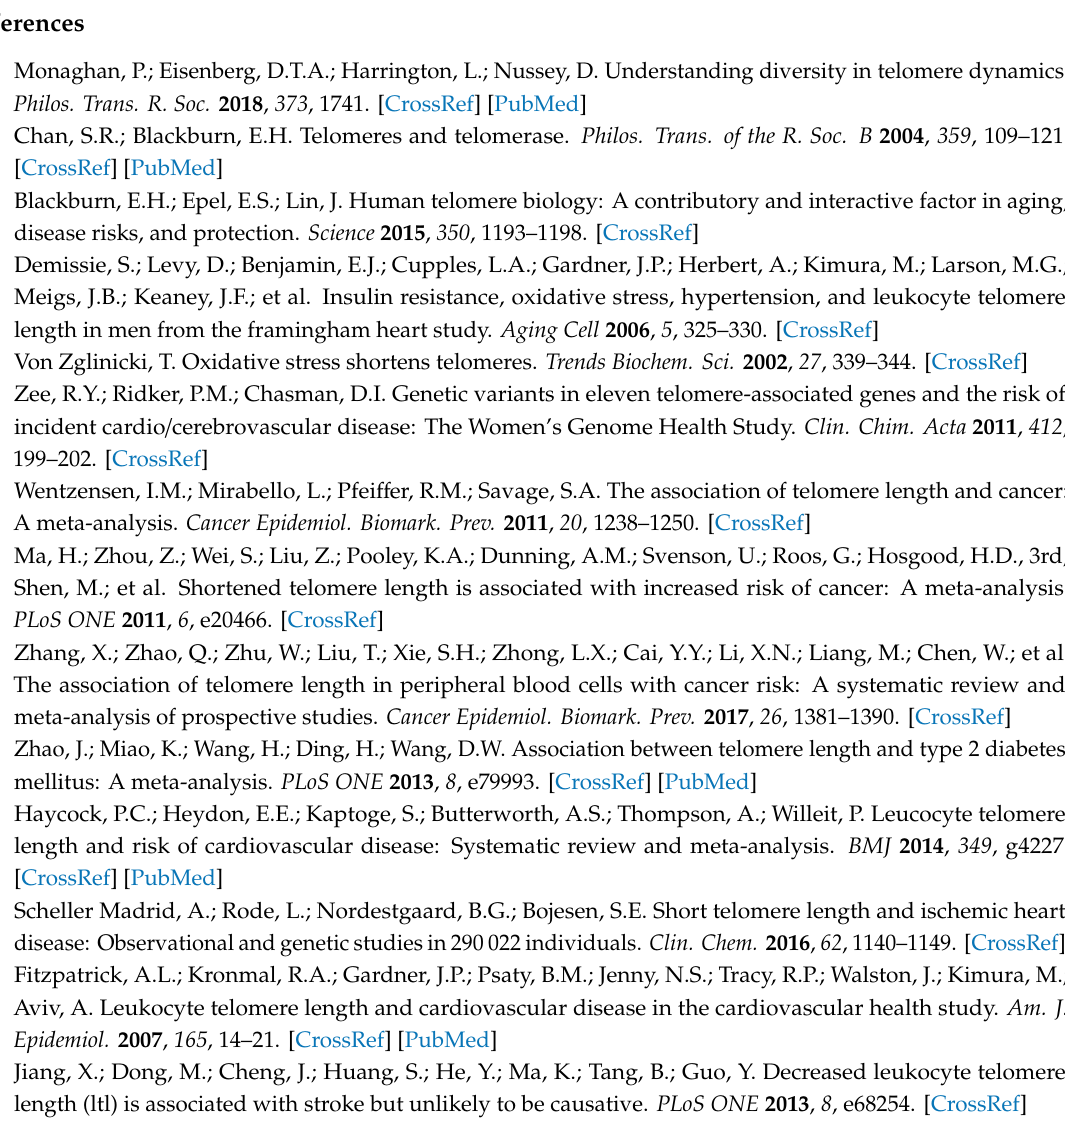
Figure S1: Data workflow from qPCR measurements to population taken forward to statistical